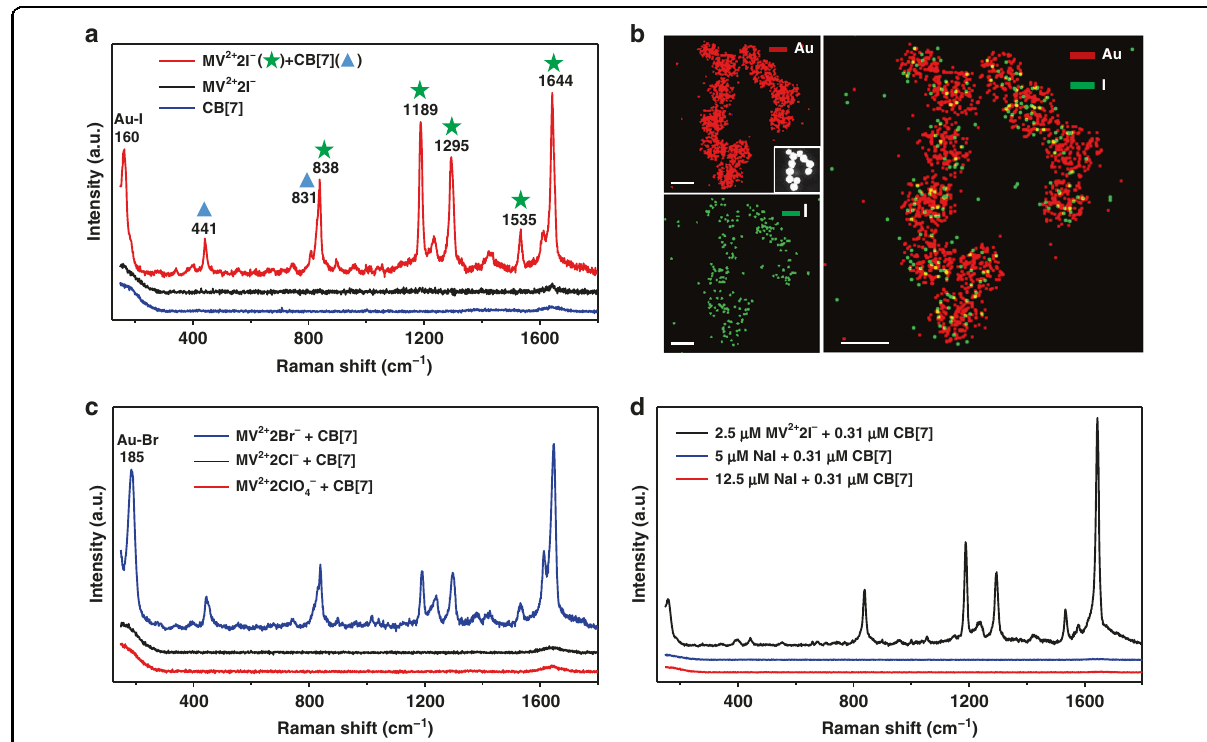
Fig. 3 Cooperative adsorption of counter anions, MV 2 + , and CB[7] on Au NPs surface. a SERS spectra of Au NPs colloid on the addition of (MV 2 + 2I − + CB[7]), MV 2 + 2I − , and CB[7], respectively. The concentrations of MV 2 + 2I − and CB[7] are 2.5 μ M and 0.62 μ M, respectively. b STEM elemental mappings of Au NPs aggregates on the addition of MV 2 + 2I − (2.5 μ M) + CB[7] (0.31 μ M). The inset shows the corresponding high-angle annular dark- fi eld image. All the scale bars represent 50 nm. c SERS spectra of Au NPs colloid on the addition of MV 2 + 2Br − (2.5 μ M) + CB[7] (0.31 μ M) and MV 2 + 2Cl − (2.5 μ M) + CB[7] (0.31 μ M), respectively. d SERS spectra of Au NPs colloid on the addition of different concentrations of CB[7] + MV 2 + 2I −